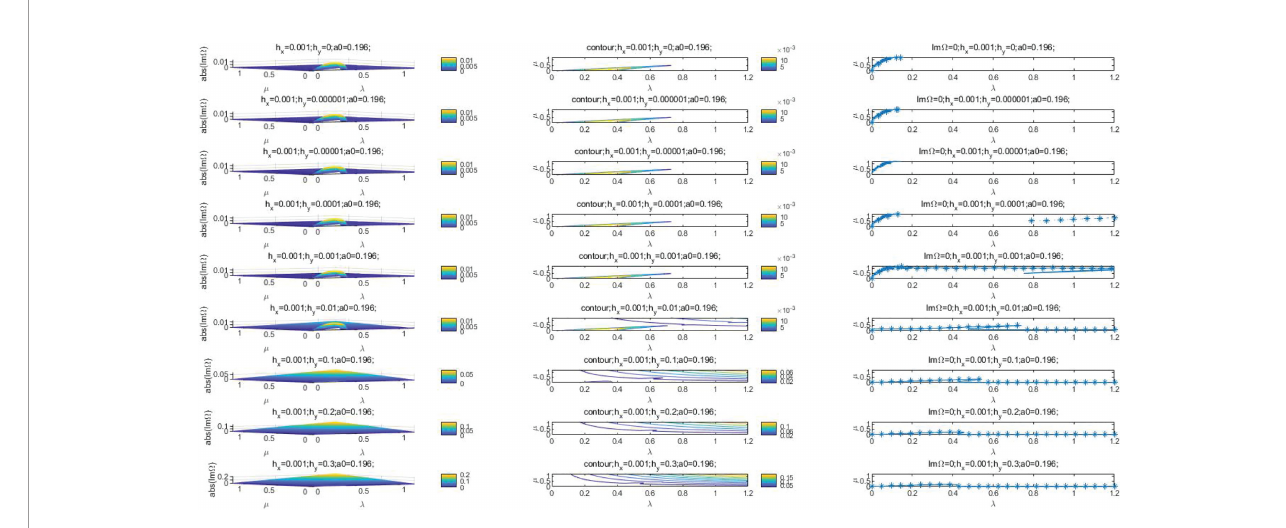
FIGURE 7 | Curves of ǀ Im W ǀ and Im W = 0 for a 0 = 0.196 and ∂ h ∂ x = 0 : 001.